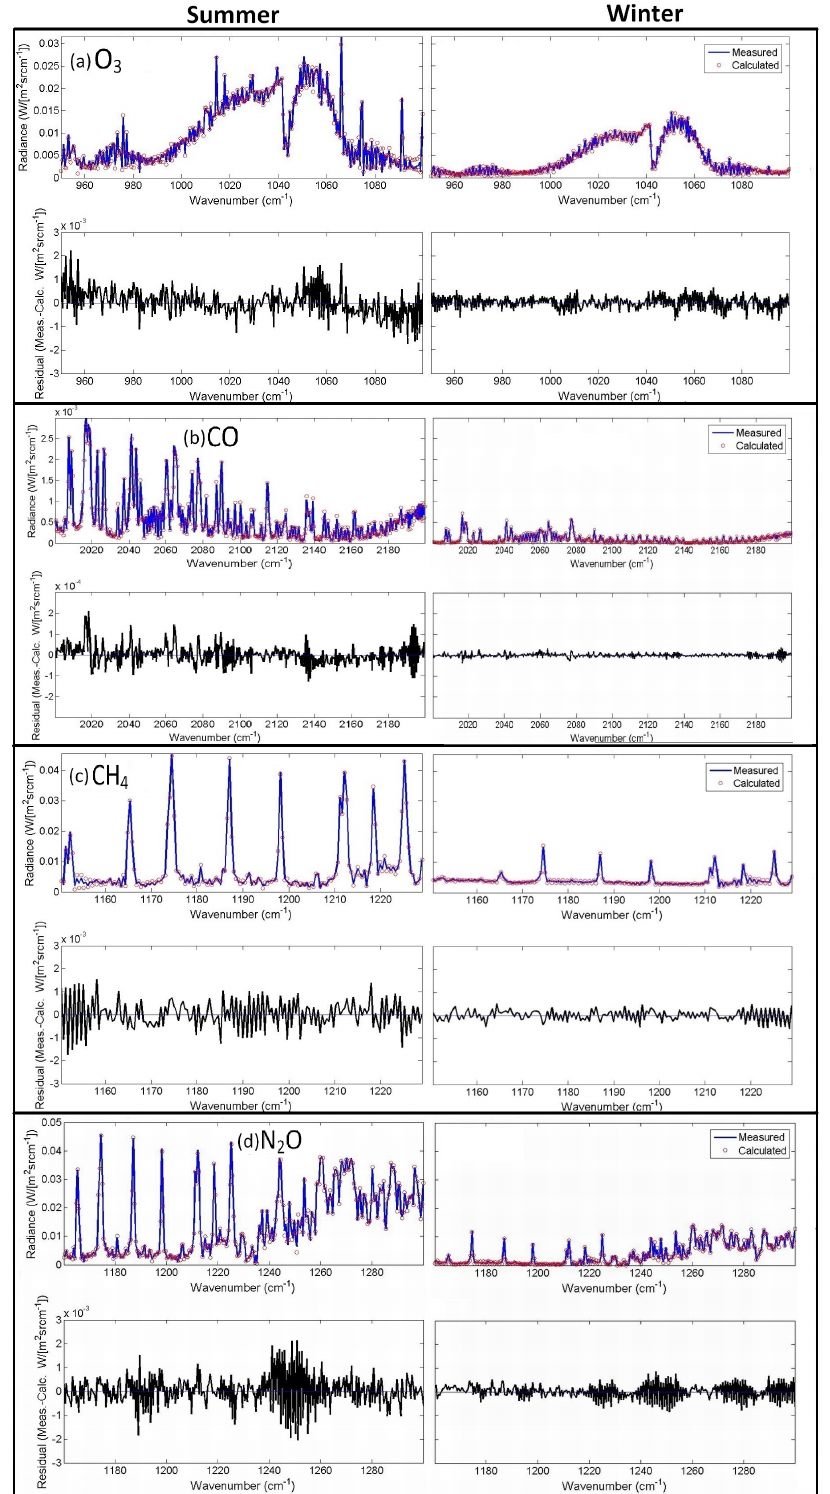
Fig. 2. Sample summer (29 June 2009; left column) and winter (31 December 2008; right column) of spectral fits for retrievals of (a) O 3 , (b) CO, (c) CH 4 , and (d) N 2 O. Top panels show the measured (blue) and fitted spectra (red circles), with their residuals shown in the bottom panels. Note the vertical scales are kept constant left-to-right while the residuals are on a finer scale. Retrievals were performed using SFIT2 and hourly averaged E-AERI